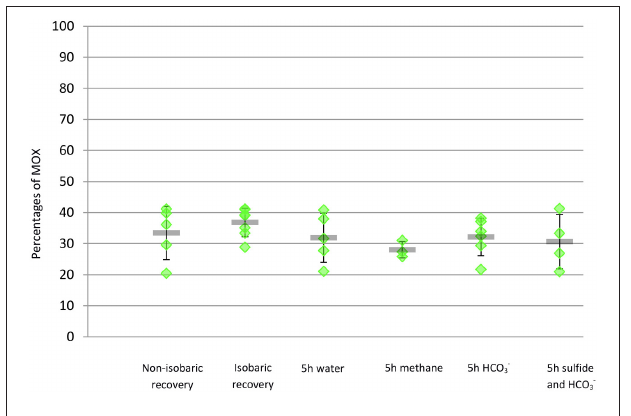
FIGURE 3 | Percentage of area occupied by methane-oxidizers vs. total bacterial area (comprising methane- and sulfide-oxidizers) in transverse sections of gill filaments of individual mussel specimen from each treatment (green diamonds). Mean value and standard deviation within each treatment are provided (gray line and error bars).